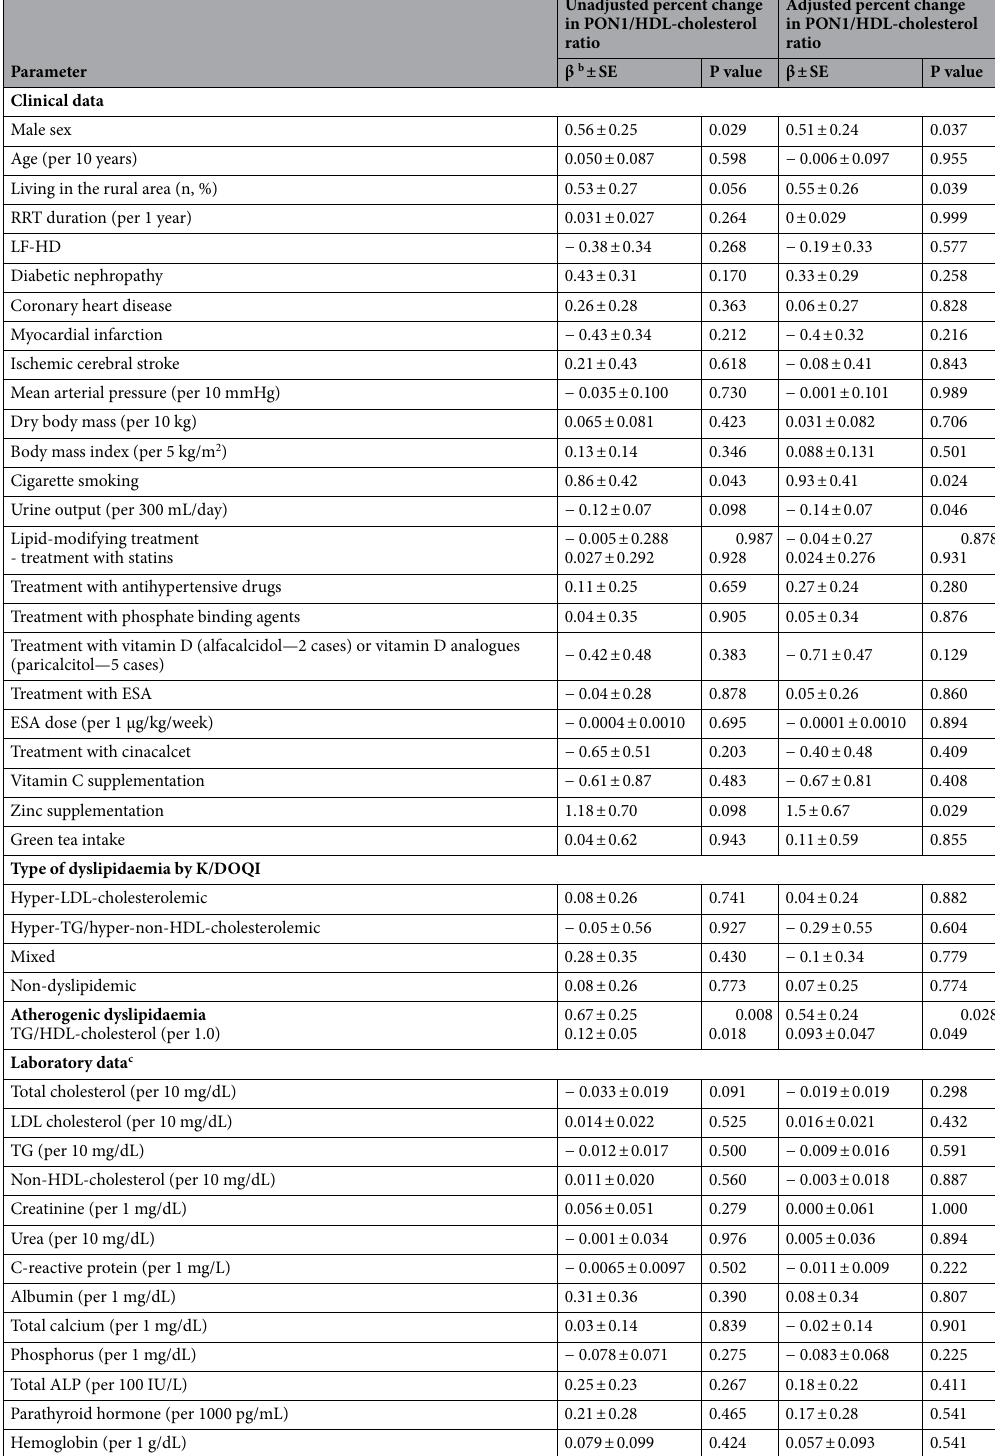
Table 7. Correlates of the normalized serum PON1 activity (PON1/HDL-cholesterol ratio). ALP alkaline phosphatase, ESA erythropoietin-stimulating agent, HD haemodialysis, HDL high-density lipoprotein, LDL— low-density lipoprotein, LF-HD low-flux haemodialysis, PON1 paraoxonase 1 gene, RRT renal replacement therapy, TG triglycerides. a Gender, cigarette smoking, urine output, living in a rural area, and serum phosphorus were used for adjustment in the multiple regression analysis. b β coefficient can be interpreted as the percent change expected in serum PON1activity for each unit change in the tested variable. c HDL- cholesterol and lipid indices calculated using HDL-cholesterol were not included in this analysis due to mathematical